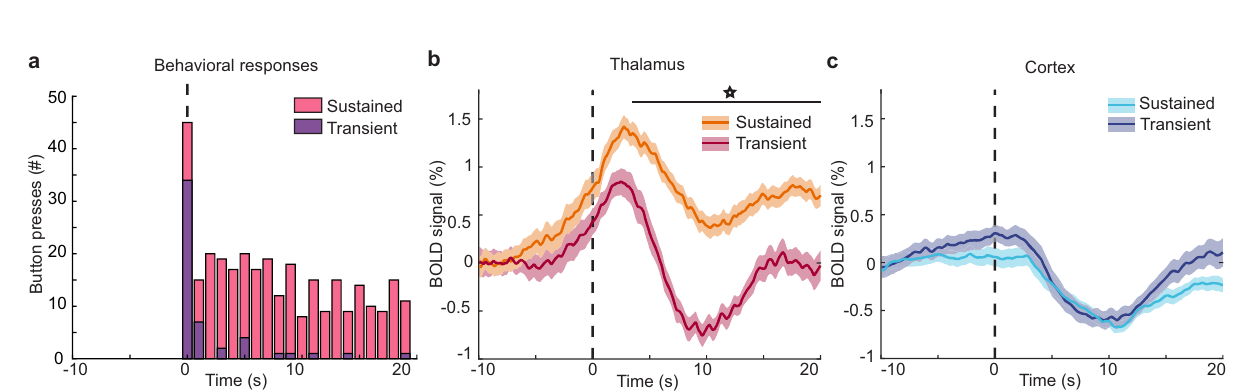
Fig. 5 | Hemodynamic latencies cannot explain the arousal-locked temporal dynamicsinthethalamus.a fMRIsignalsincreaseafterbreathholdrelease(purple dashed line). The time of the breathhold is shaded in light purple. The thalamus leads the cortex by 0.12s. Data were presented as mean values, and shading represents standard error. b Small hemodynamic lags between thalamic nuclei exist but are not large enough to account for the arousal-locked sequence. The color and ordering of thalamic nuclei represent the lag sequence during arousal.